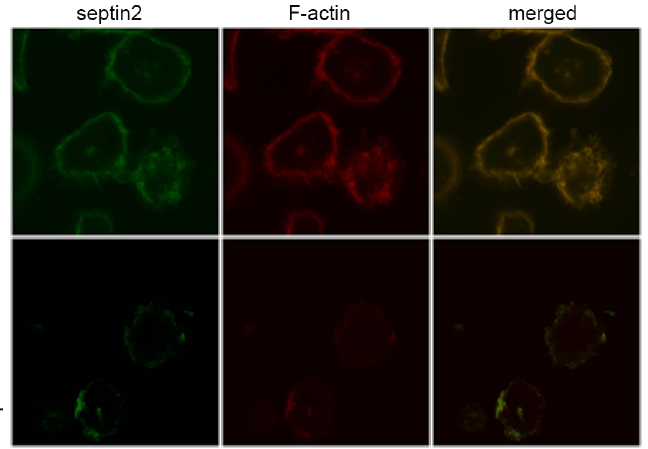
Fig 4. Transfection of SEPTIN2 siRNA resulted in cytoskeleton change in L428 cells. The Rhodamine- phalloidin was applied for visualizing F-actin . The overlay shows co-localization in yellow.